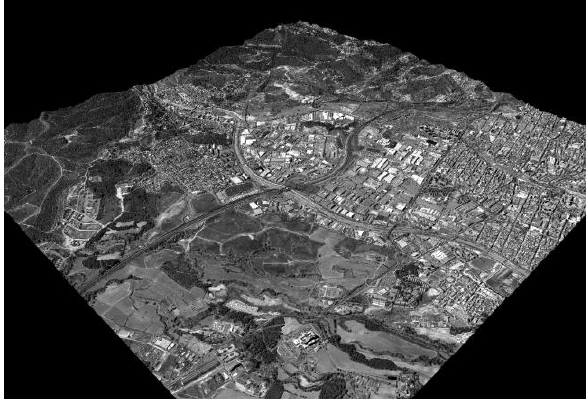
Figure 2. Terrassa area. 3D visualization of textured DSM from WorldView-1 stereo scenes.